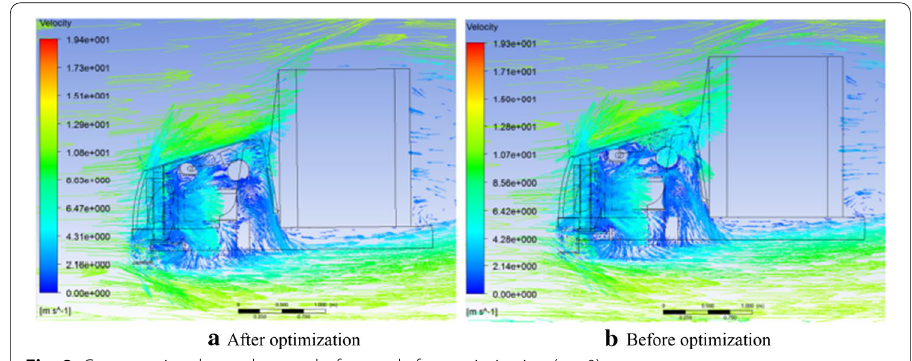
Fig. 8 Cross‑sectional speed vector before and after optimization ( x